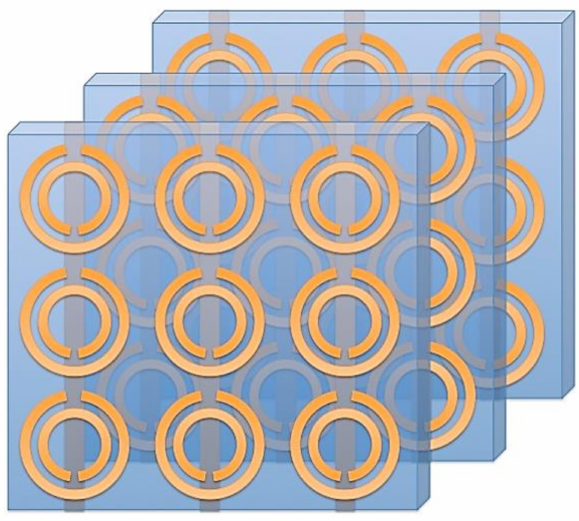
Figure 1. Pictorial representation of a metamaterial